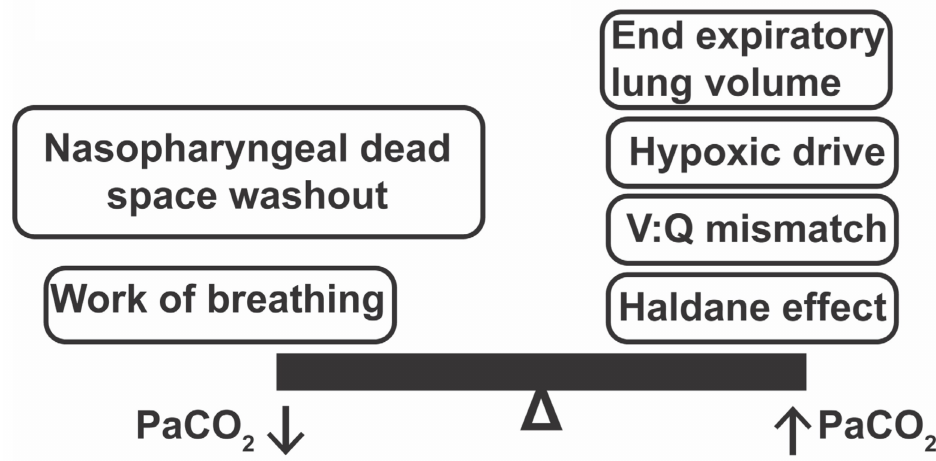
Figure 1. Physiologic mechanisms that may improve or worsen hypercapnia when implementing HFNC in a patient with structural lung disease like COPD. V:Q mismatch = Ventilation : Perfusion